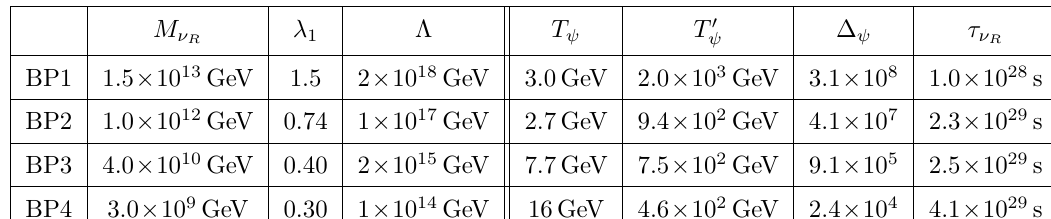
Table 2 . The BPs for the superheavy RHN DM scenario. g B − L = 1 , λ R = 0 . 1 , M ν M S = 2 M ν and λ 1 = λ 2 are fixed, and the first three columns M ν R coupling) and Λ ( Z 2 breaking scale) are free parameters. The ψ decay temperature T ψ and reheating temperature T 0 , dilution factor ∆ ψ and the DM life time τ ν ψ where H = 100 h km / s / Mpc (with h = 0 . 674 ) and s 0